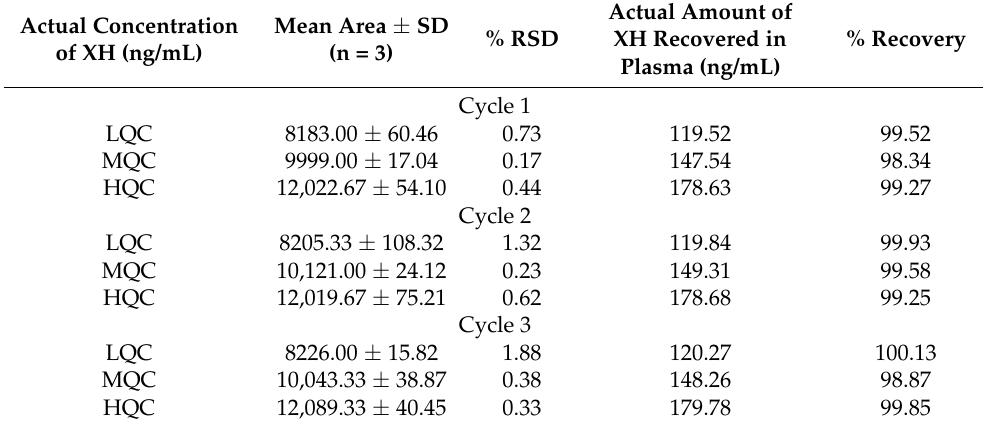
Table 5. Freeze thaw stability for plasma samples of XH.